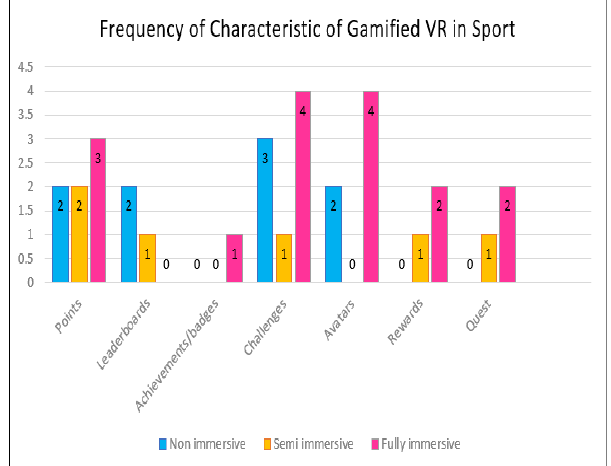
Figure 4 . Frequency of Characteristic of Gamified VR in